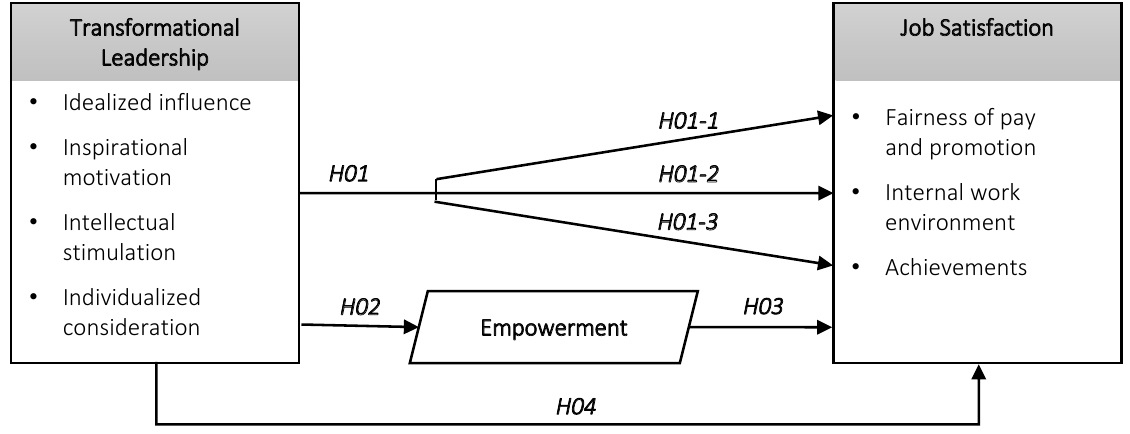
Figure 1. Conceptual